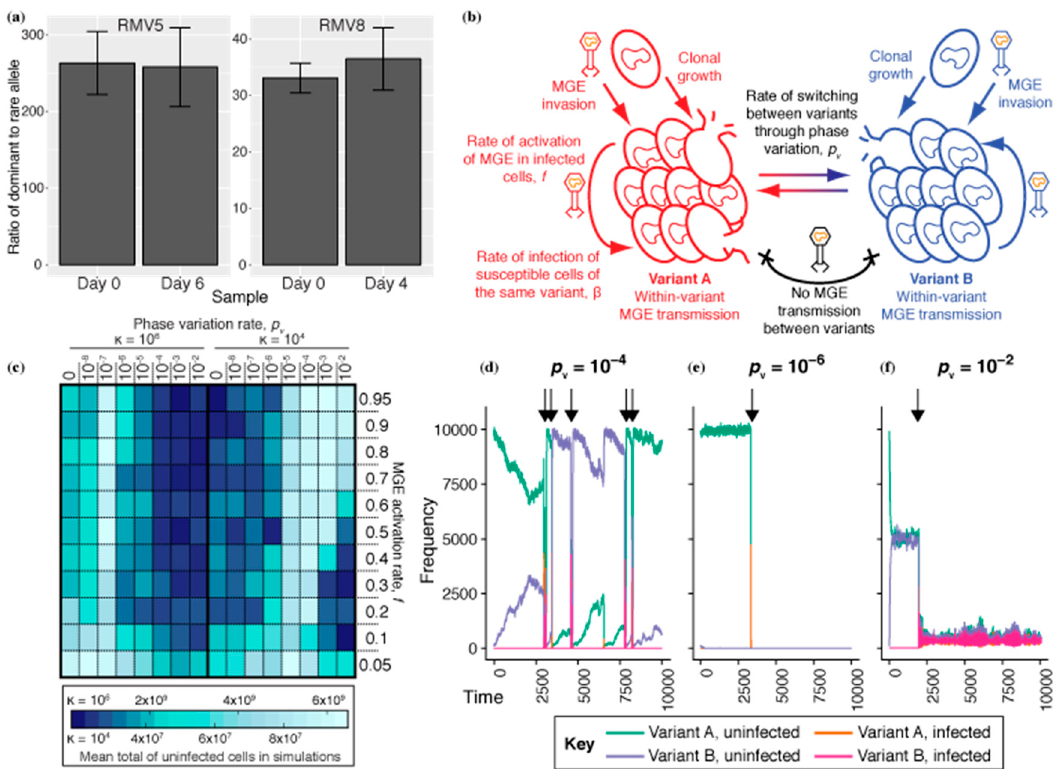
Figure 1. The role of phase-variable restriction modification systems in preventing infection of S. pneumoniae by mobile genetic elements. ( a ) The lack of tvr locus randomization in S. pneumoniae strains RMV5 and RMV8. The relative abundances of different alleles at a segment of the phase variable tvr locus were measured using a specific quantitative PCR assay at the start and end of passage experiments. These bar charts show the ratio of the frequency of the dominant allele to the rare allele. The error bars show the standard error of the mean from combining three technical replicate measurements from two biological replicate experiments. ( b ) Structure of the mathematical model of an S. pneumoniae population. The population is split into variants A and B, which interchange through phase variation at a rate p v . ML MGEs intermittently invade the population. These transmit between cells of the same variant at a fixed rate, but cannot transmit between cells of different variants. ( c ) Heatmap displaying simulation results. The heatmap is split into two halves vertically, corresponding to a large ( κ = 10 6 ; left) or small ( κ = 10 4 ; right) population. Within each half, the cells correspond to a particular parameter combination, with p v determined by the column, and the rate of MGE activation, f , determined by the row. The colour of the cell represents the mean number of uninfected cells that survived over the 10 4 timesteps of the simulation, across 20 replicates. ( d – f ) Examples of simulated populations ( κ = 10 4 ) with different p v and f fixed at 0.3. The arrows above the plots indicate instances of sustained MGE transmission in the cell population. ( d ) Simulation with p v = 10 − 4 . The population survives repeated MGE sweeps through phase variation, ensuring a minority of rare variants are able to expand and replace the cells of the dominant variant killed by the MGE. ( e ) Simulation with p v = 10 − 8 . This slow rate of variation does not sustain multiple variants in the population. ( f ) Simulation with p v = 10 − 2 . At this rapid rate of interchange, MGEs undermine the restriction barrier between variants through being within cells as they switch, enabling them to infect both variants equally effectively.